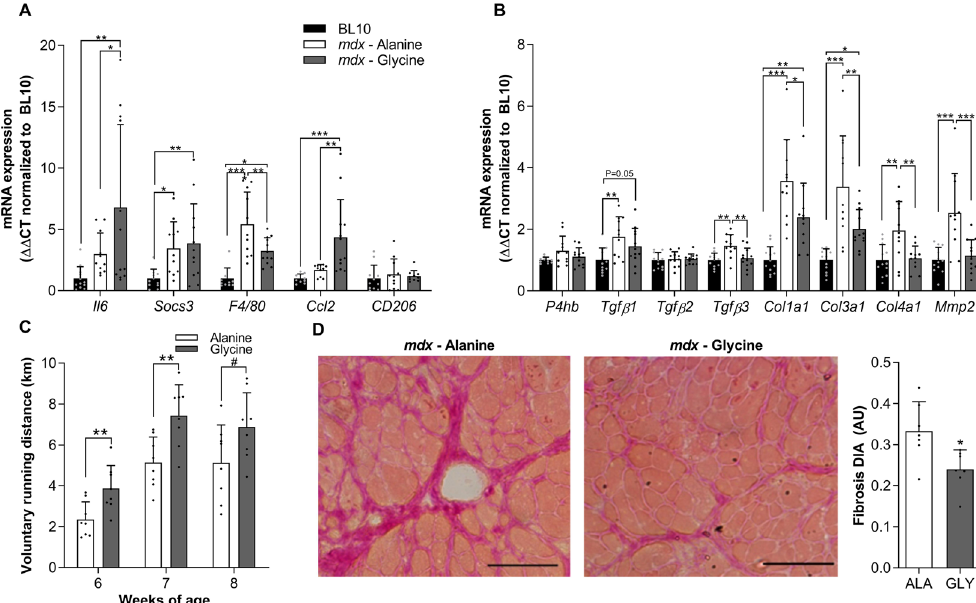
interleukin-6, Il-6 ; suppressor of cytokine signaling 3, Socs3 ; EGF-like module-containing mucin-like hormone receptor-like 1, F4/80 ; chemokine ligand 2, Ccl2 ; mannose receptor, Cd206 ) and factors involved in fibrosis/ collagen synthesis ( B) , protein disulphide-isomerase, P4hb ; transforming growth factor beta, Tgf β ; collagen type I, III and IV, Col1a1 , Col3a1 and Col4a1 and; matrix metallopeptidase 2, Mmp2 ). The PCR data are normalized to the BL/10 controls and presented as mean ± SD of 10–12 animals per group. The effect of chronic glycine feeding on running performance in mdx mice ( C ) compared to L-alanine (control). Representative muscle cross-sections stained with Van Gieson’s to visualize collagen and its quantification from mdx mice after chronic treatment with glycine ( D ). Scale bar represents 100 µ m. Data were analyzed using one-way ANOVAs with Fishers LSD post hoc test. * denotes p < 0.05; ** denotes p < 0.01; *** denotes p <